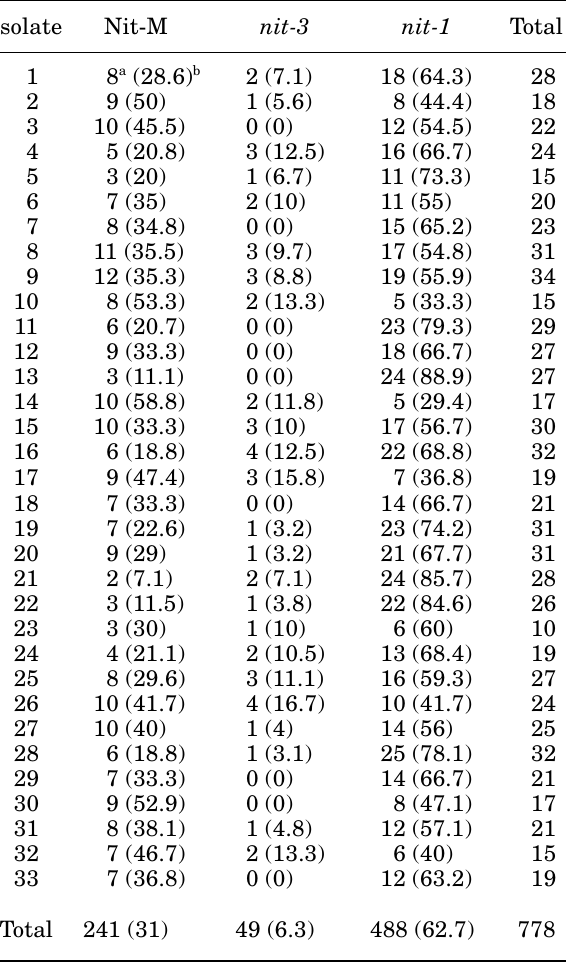
Table 4. Number of each nit- mutant type selected on characterization